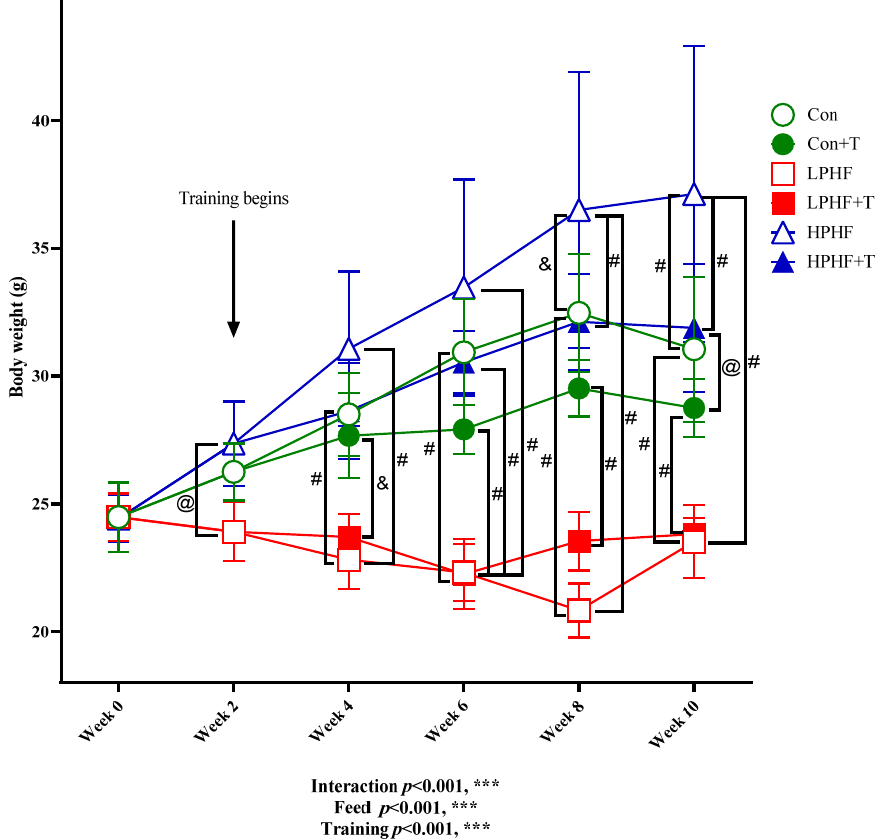
Figure 1. Changes in body weight throughout the experiment. Con, Con+T, LPHF, LPHF+T, HPHF, and HPHF+T represent chow diet, chow diet plus training, low-protein high-fat diet, low-protein high-fat diet plus training, high-protein high-fat diet, and high-protein high-fat diet plus training, respectively. Feed, training, and interaction indicate a dominant effect of diet, treadmill exercise, and the interactive effect between feed and training, respectively. *** p < 0.001. @, p < 0.05; &, p < 0.01; #, p < 0.001. Data are presented as the mean ± SD. n = 8 for each group. Significance of differences between means was determined by Tukey’s post hoc test when ANOVA revealed a significant effect from the interaction of diet and training.